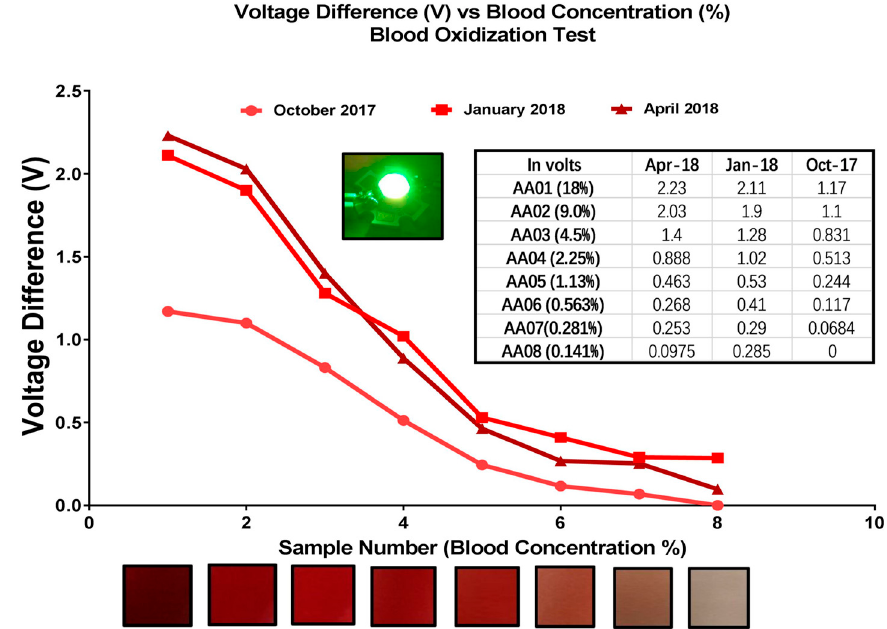
Figure 5. The blood concentration samples were kept for around one year were tested using Green Light Spectrum. Experimental results have shown that blood concentration samples more than 4.5 percent have a darker color, indicating that oxidization has occurred in the blood samples.